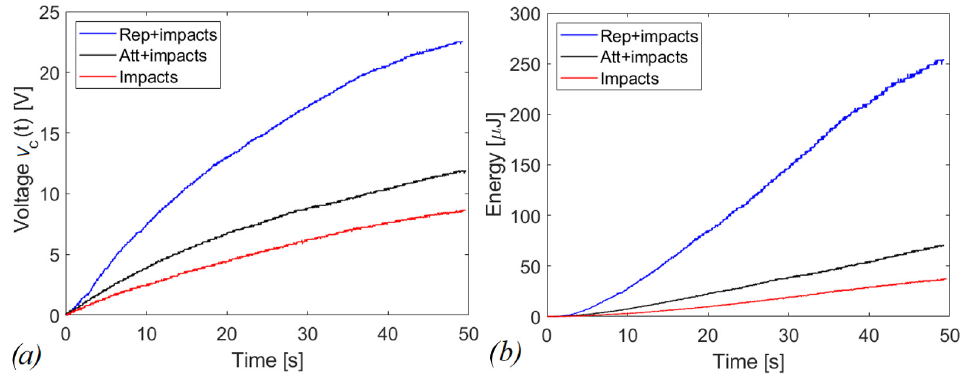
Figure 16. ( a ) voltage and ( b ) energy harvested in case of shaking with capacitive circuit (C 1 = 1 μ F).